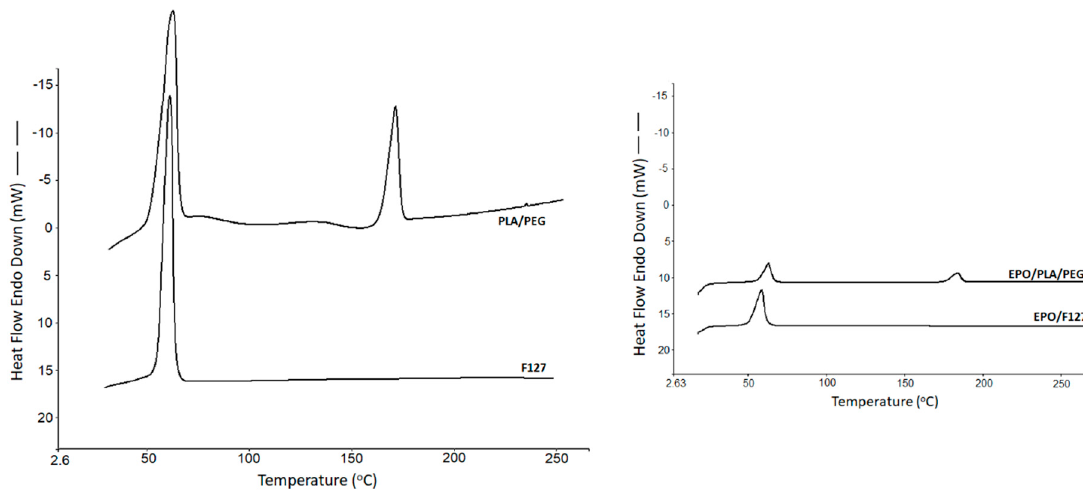
Figure 6. DSC thermal transitions of the blank polymeric formulations and the scaffolds.